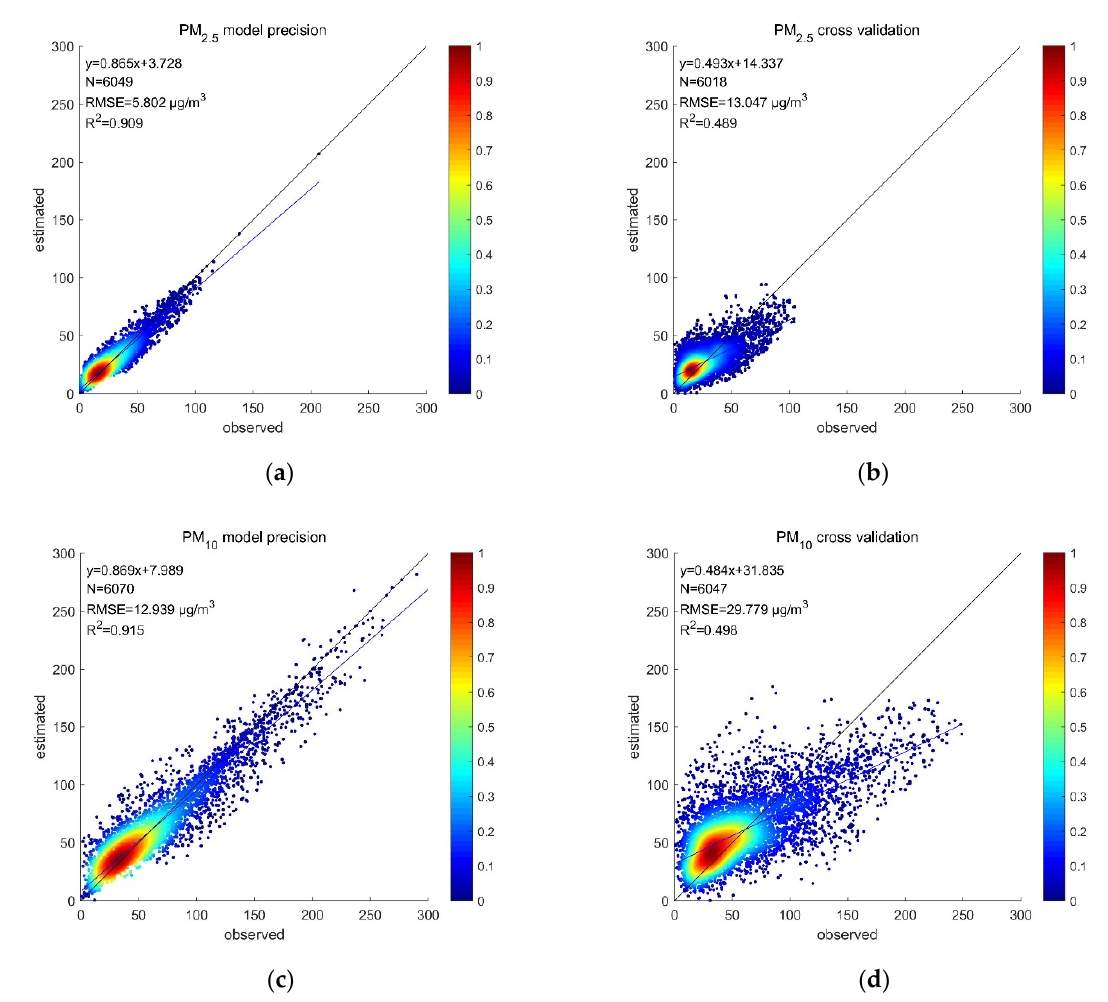
Figure 2. Scatter plots for ( a ) model fitting result and ( b ) tenfold cross-validation results for PM 2.5 . Scatter plots for ( c ) model fitting result and ( d ) tenfold cross-validation results for PM 10 . The colour represents the sample density.